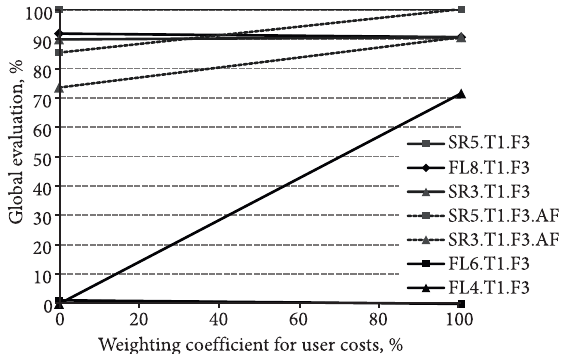
Fig. 5. Sensitivity analysis of the global evaluation in relation to the environmental costs (traffic